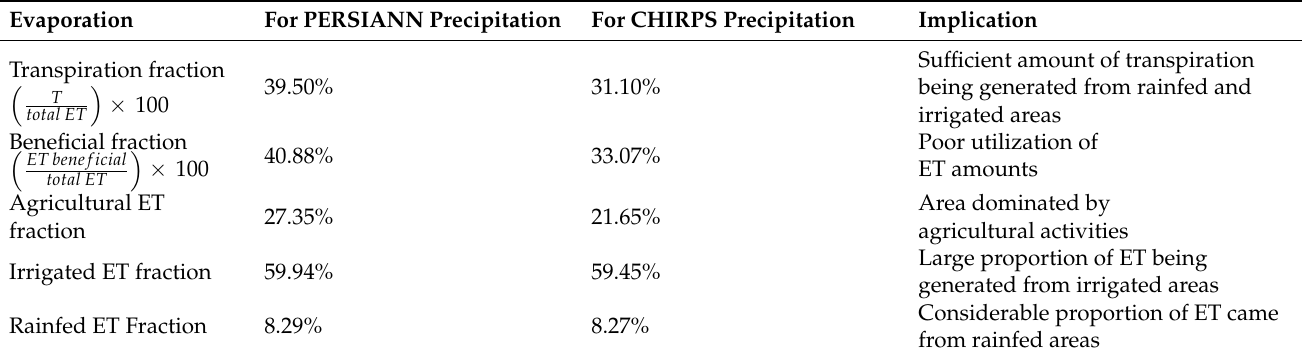
Table 6. Performance indicators based on satellite precipitation datasets for dry year in the Betwa River